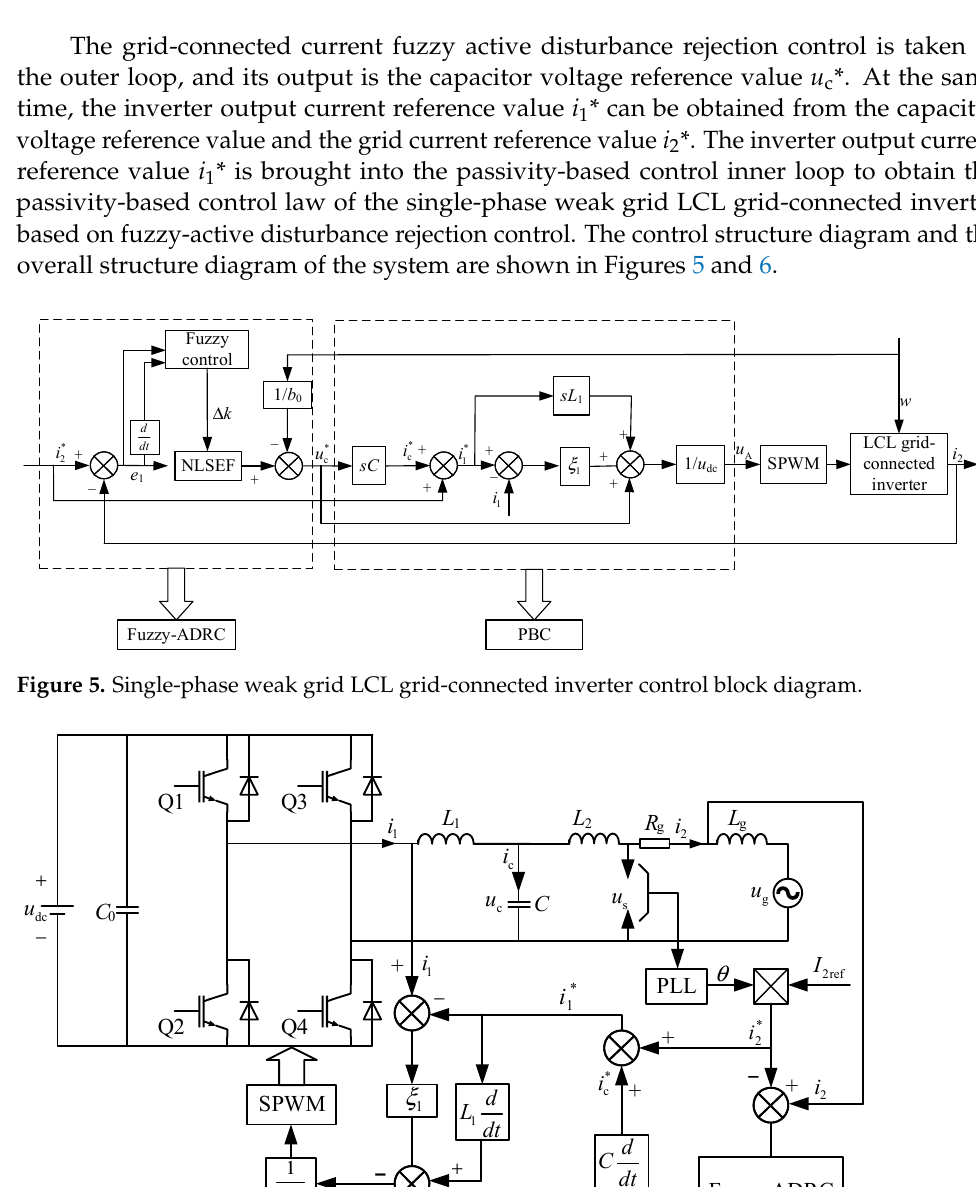
Figure 6. The overall structure diagram of single-phase weak grid LCL grid-connected inverter.